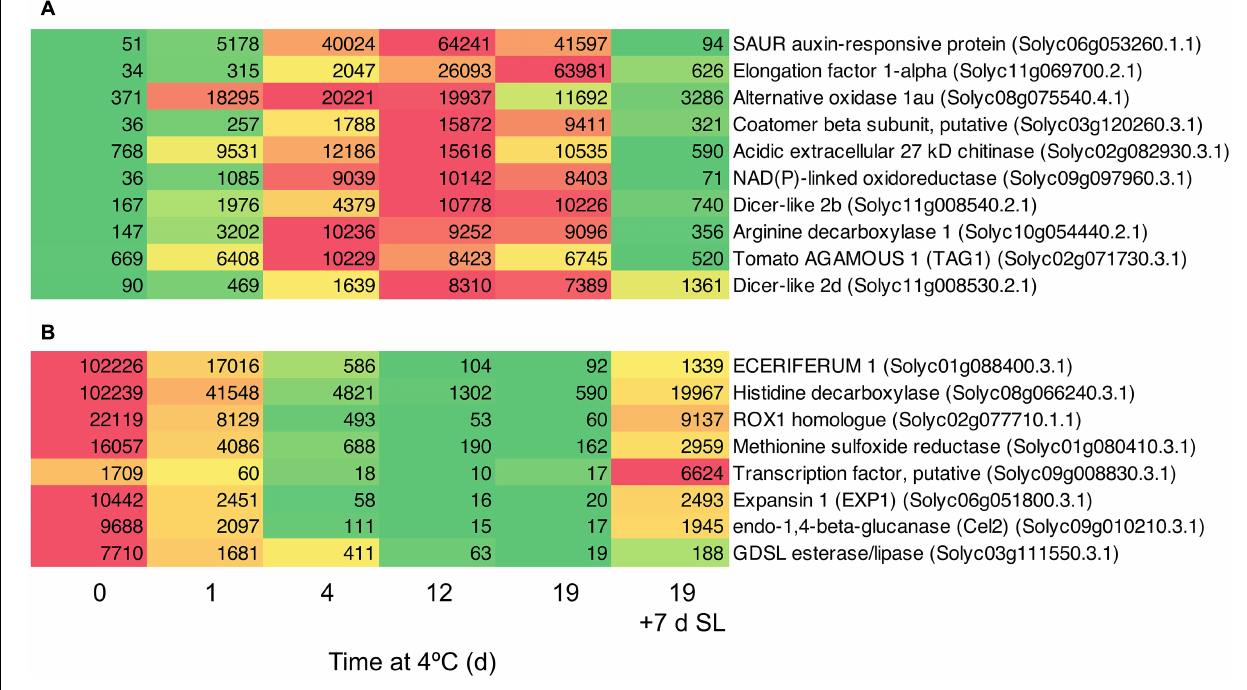
FIGURE 8 | Heat maps showing genes strongly differentially expressed in response to storage at 4 ◦ C. An additional 7-day period at a shelf-life (SL) temperature of 20 ◦ C was also included after 19 days. (A) Transcripts showing very large fold changes up in response to temperature. (B) Transcripts showing very large fold changes down in response to temperature. Red and green colors represent high and low mRNA abundance, respectively, within each transcript. Numbers in the boxes are DESeq2 mean normalized counts using the median of ratios